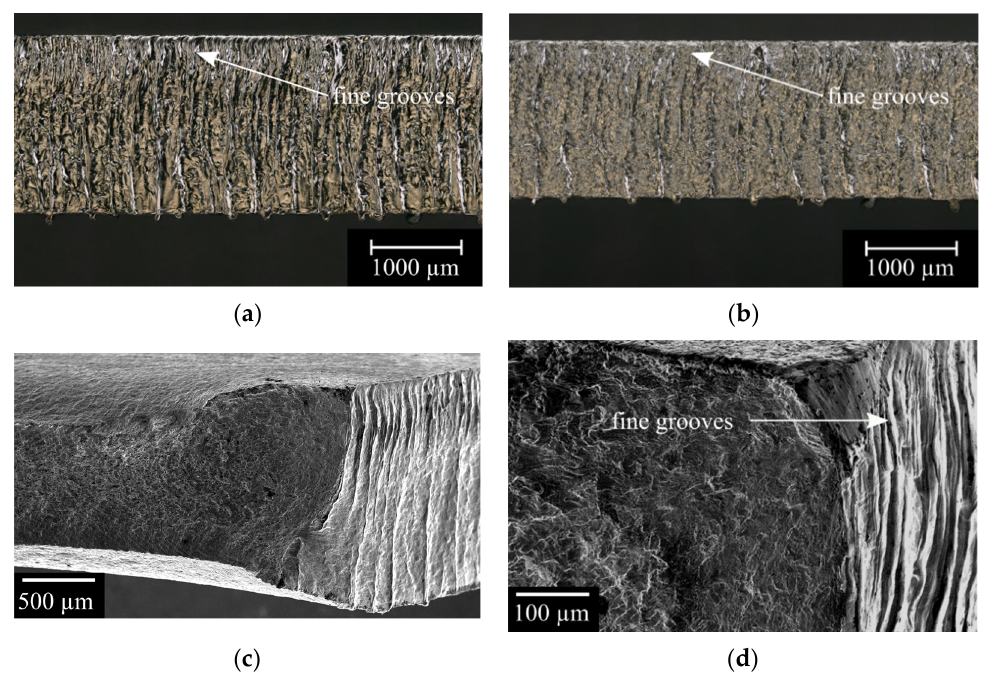
Figure 8. Crack initiation origin of a representative specimen with small droplets in the states ( a ) before pre-deformation and ( b ) after pre-deformation. ( c ) SEM image of the crack initiation region. ( d ) Enlarged SEM image of the crack initiation site with fine grooves.